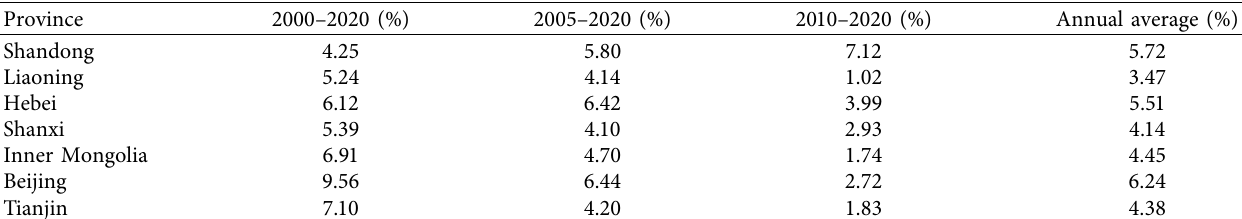
Table 3: Forecast value of annual energy intensity reduction in each